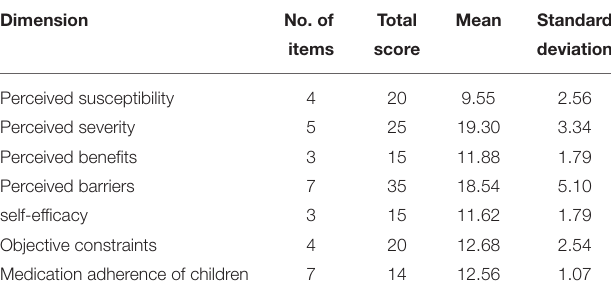
TABLE 3 | Scores of dimensions in structural equation model. Dimension No.